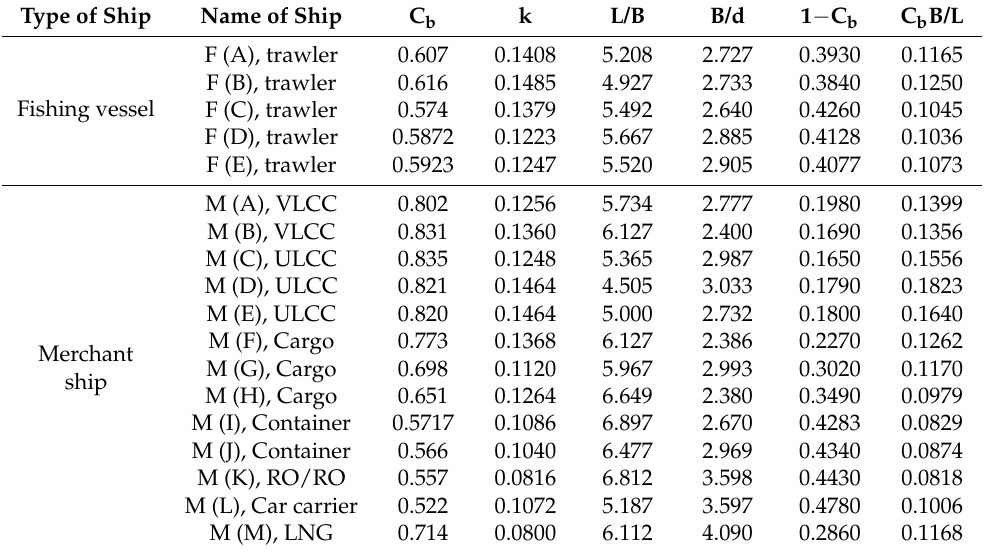
Table 1. Hull shape parameters of 18 ships. Type of